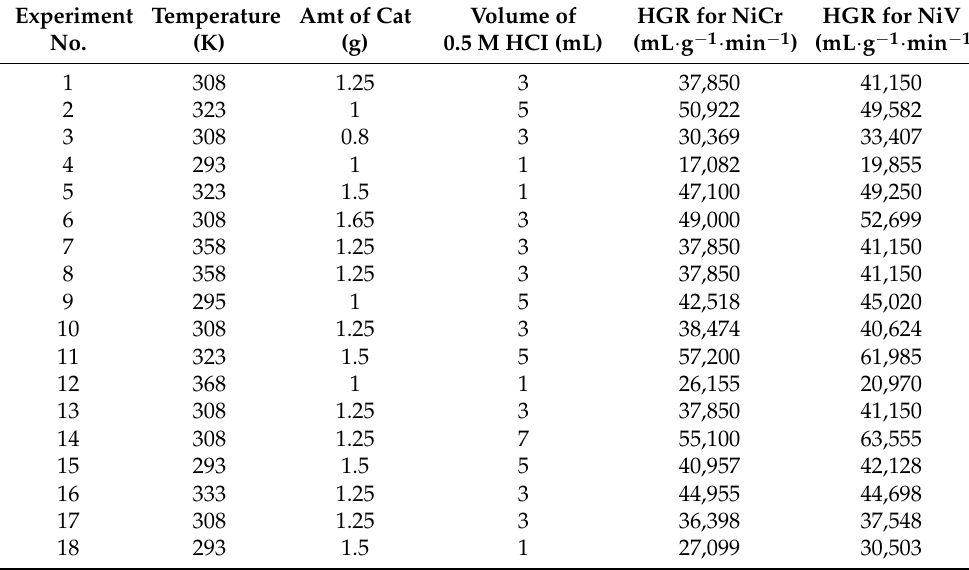
Table 1. Experimental plan and HGR